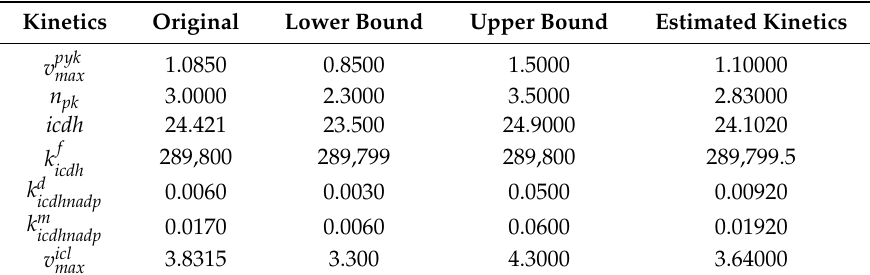
Table 2. Kinetic parameters